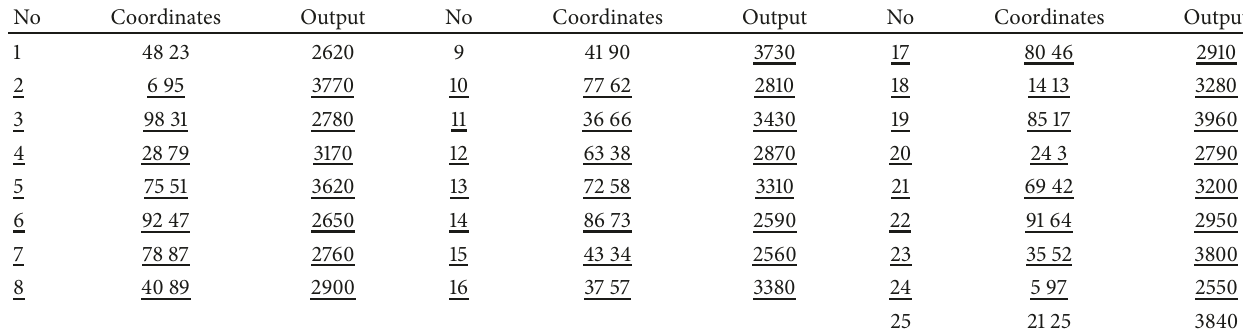
Table 7: Coordinates and quantity of